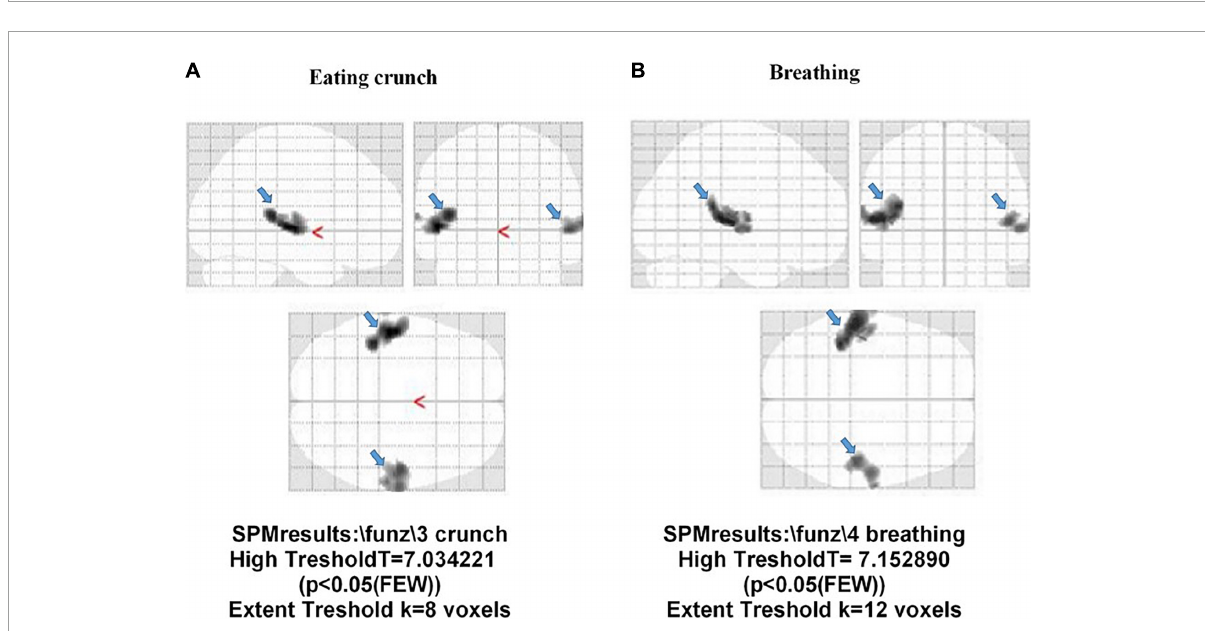
FIGURE7 Activation of the auditory cortex (BA 41 and 42; light blue arrow) in two participants without misophonia. The stimulus administered was “eating crunchy” in panel (A) , and “breathing” in panel (B)